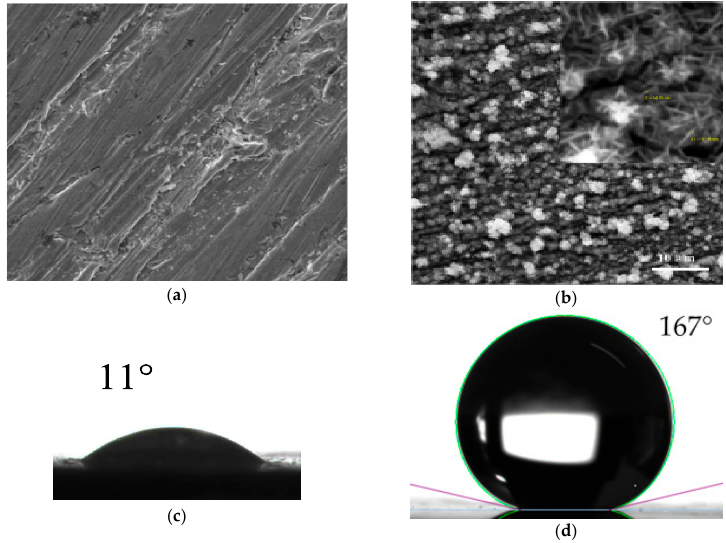
Figure 2. SEM images of ( a ) untreated rotor ball surface and ( b ) the rotor ball surface with fabricated nanosheets; Optical photos of a water droplet on ( c ) untreated carbon steel sheet surface and ( d )